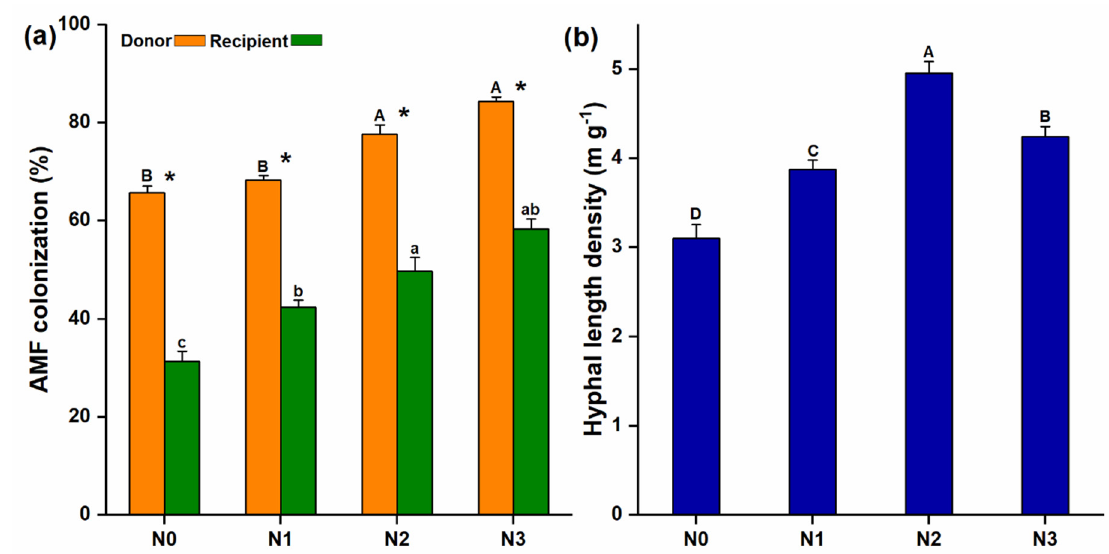
Figure 2. Arbuscular mycorrhizal (AM) fungi colonization and the development of common mycorrhizal network; ( a ) AM fungal colonization was observed in both donor and recipient plant; ( b ) After inoculation, extraradical hyphae were developed, which were measured from the hyphal compartment; the same lowercase and uppercase letters indicate non-significant differences among different N treatments of the respective donor and the recipient plants, while (*), shows a significant difference between donor and recipient plants at different N-treatments. Table 1. Mean squares of absolute values for various traits under mycorrhizal and non-mycorrhizal treatment and significance of main treatment e ff ects (N and Fungus) and their interaction e ff ects (N × Fungus) based on two-way ANOVA.